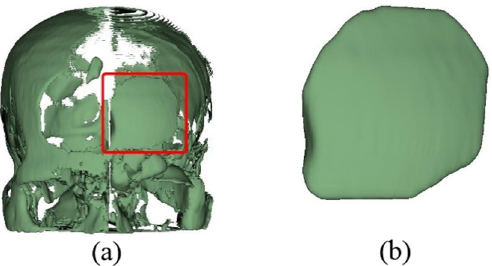
Figure 6. Mirror based modelling: ( a ) subtract between the mirror and reference models, ( b ) remove residual and smoothen the